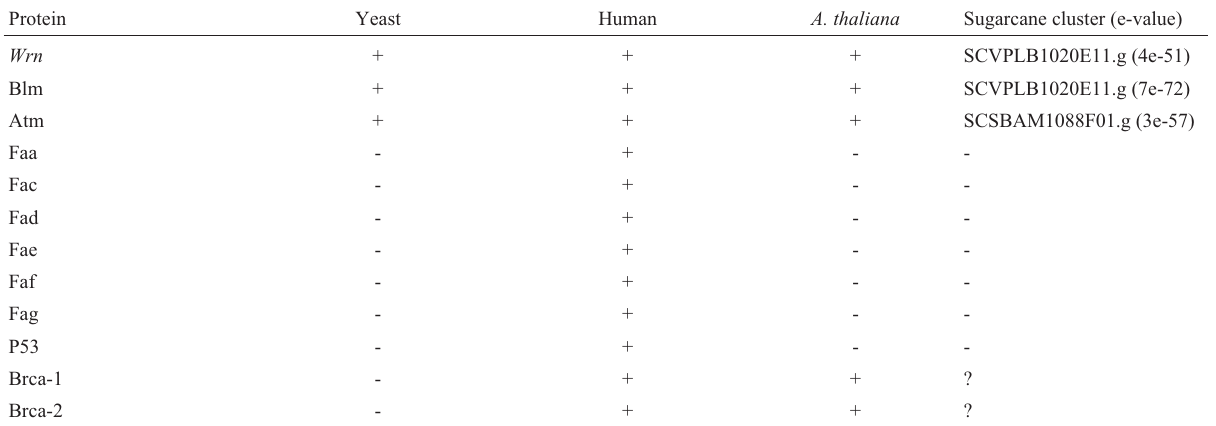
Table VII - Presence (+) or absence (-) of human hereditary disease proteins in different organisms. Protein